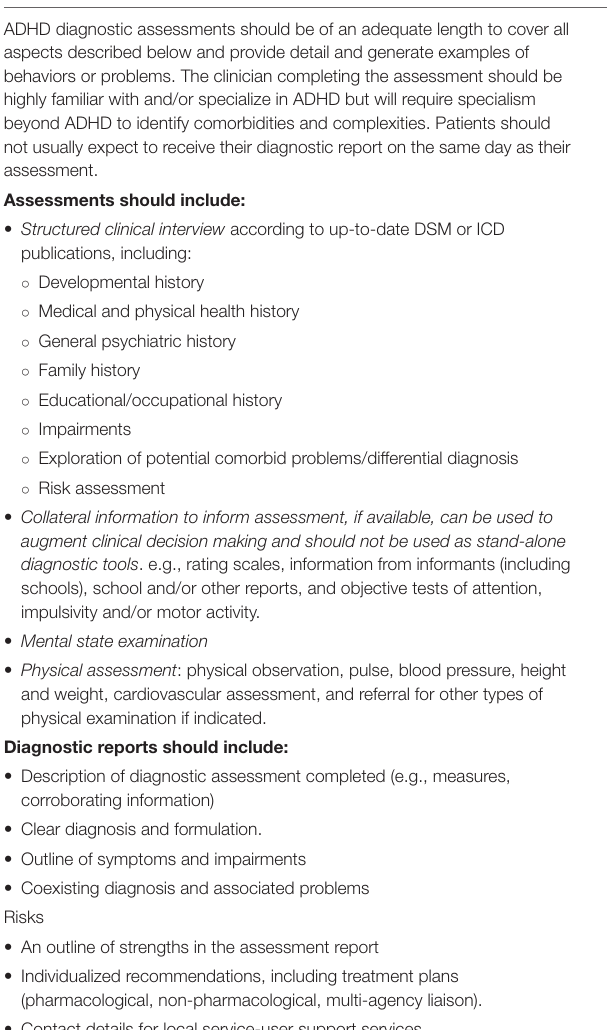
TABLE 1 | Minimum standards for ADHD assessment and